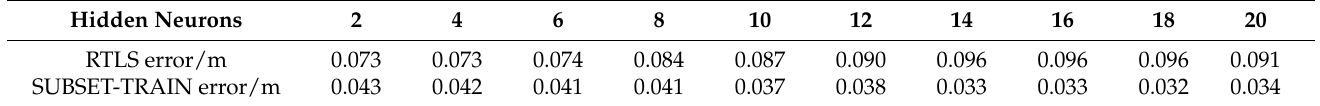
Figure 16. Mean error over all six tags’ poses for the NN models with the number of neurons from 2 to 20 with increments of two using data from the training experiment, that were not used in the NN’s training process. Table 3. Mean error over all six tags’ poses for a different number of hidden neurons in the NN model. The first row, RTLS, presents model errors when measured distances from the RTLS experiment were used. The second row, SUBSET-TRAIN, presents model errors when a subset of data from the training campaign was used that was not included in the NN model’s training process.